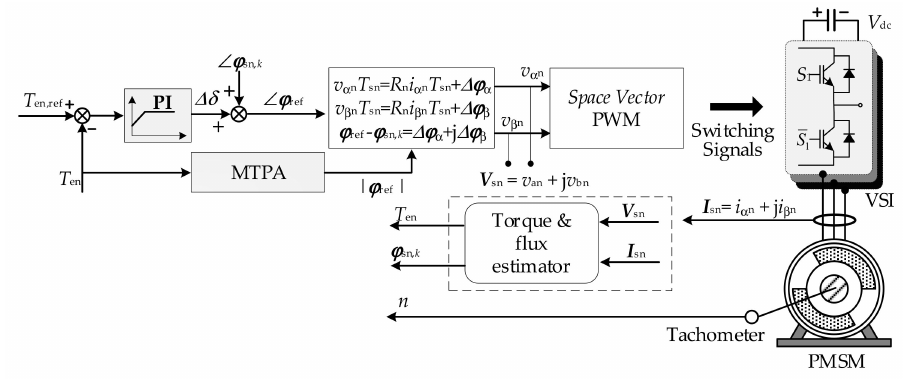
Figure 1. The conventional direct torque control with space-vector modulation (DTC-SVM)